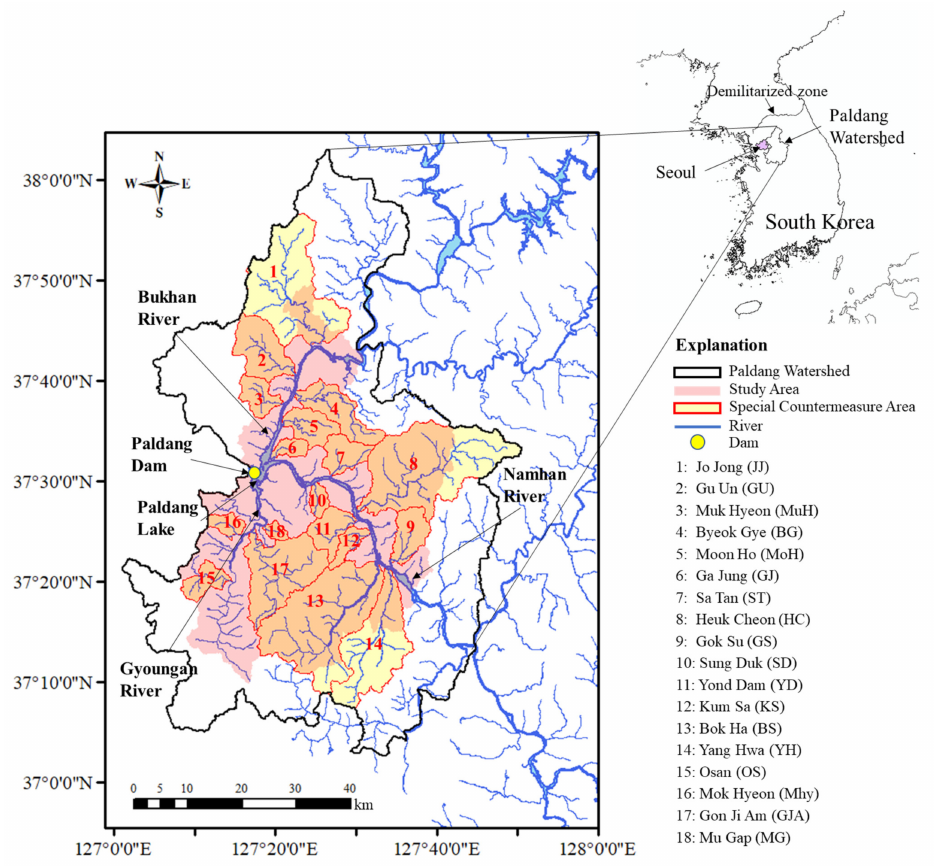
Figure 1. Scheme of study